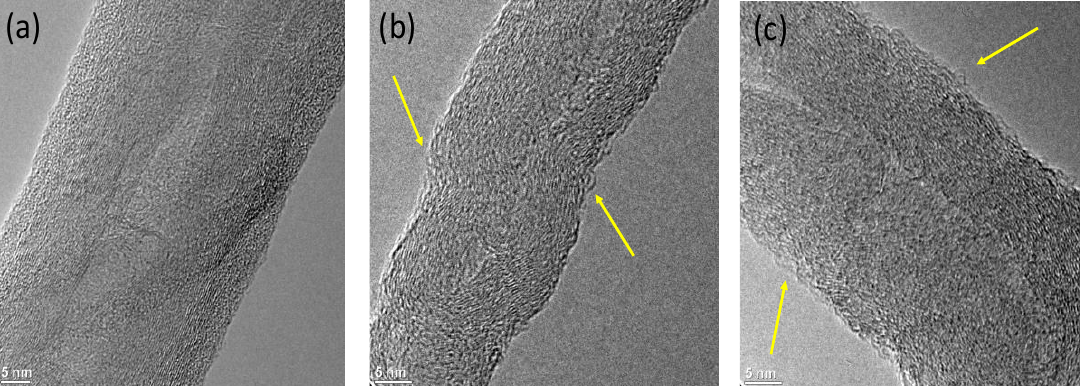
Figure 6. Transmission electron microscopy (TEM) images of ( a ) MWCNT, ( b ) MWCNT-CA and ( c ) MWCNT-OA.